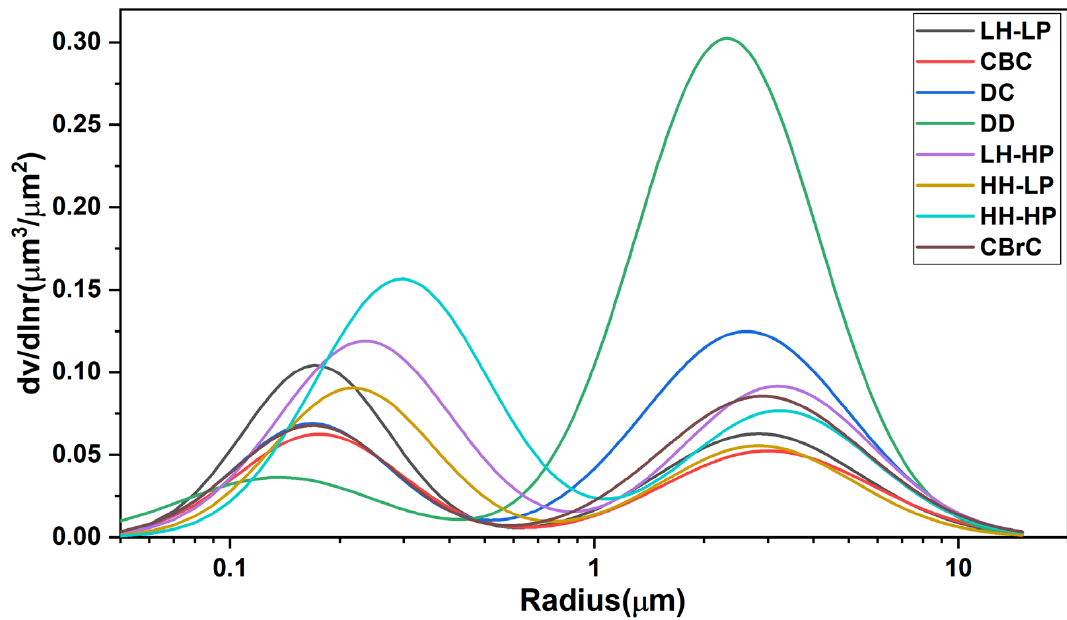
Figure 1. The size distribution of 8 aerosol models ([46]).